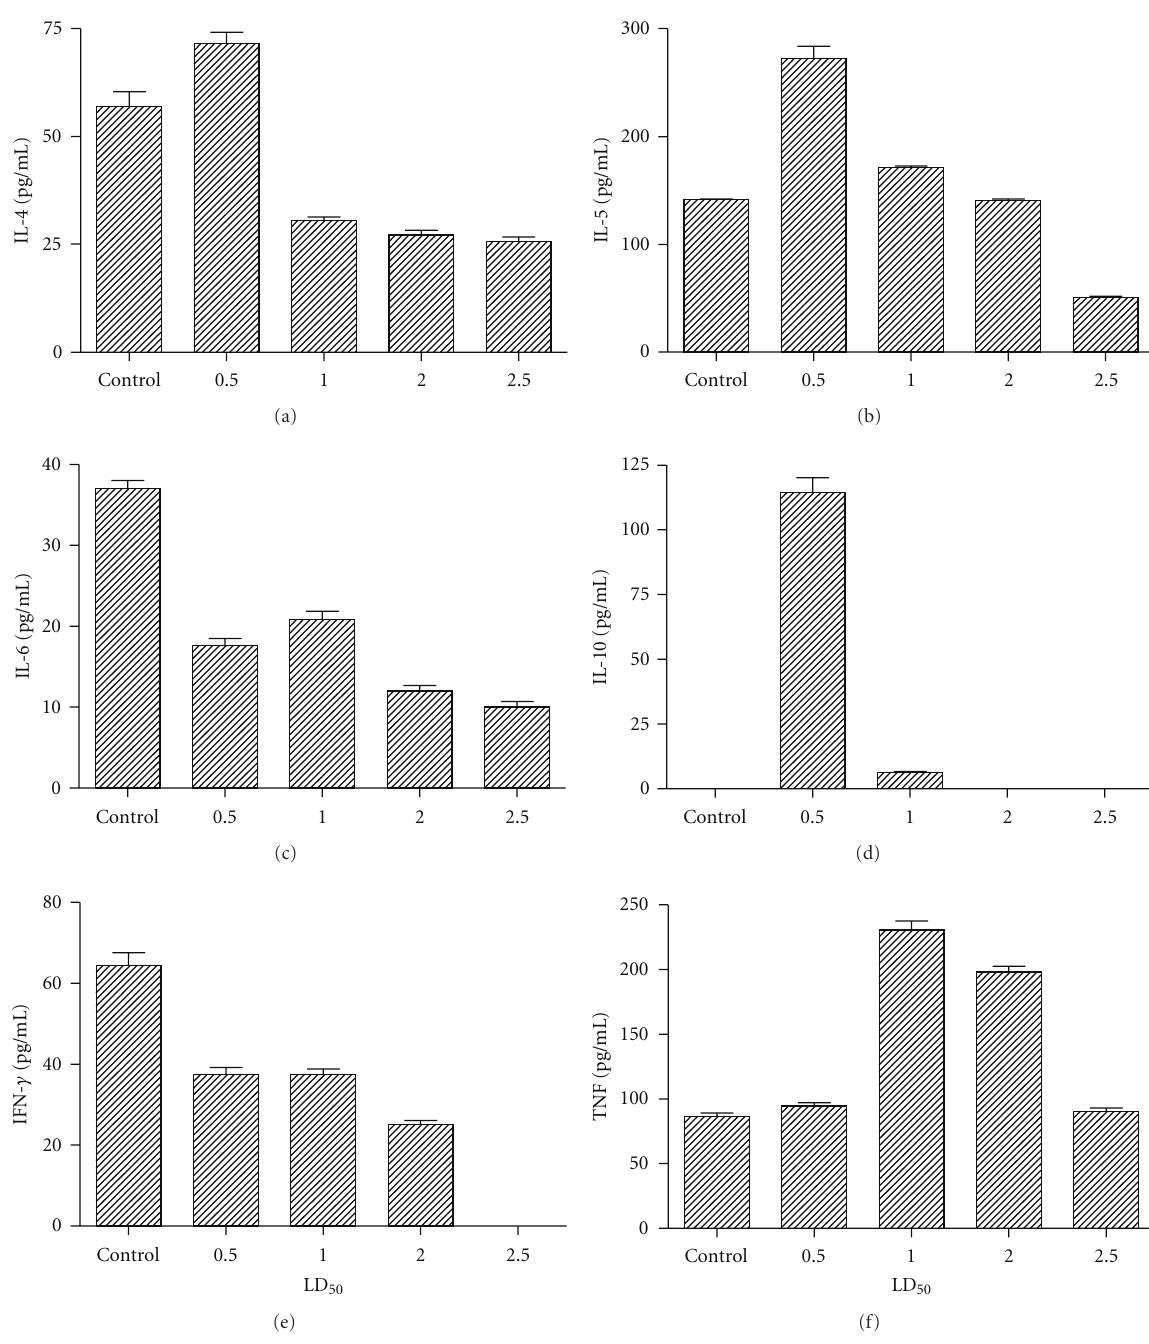
Figure 2: Cytokine excreted in urine from BALB/c female mice. Urine of mice was obtained after i.p. injection with di ff erent amounts of Cdt as above described. The levels of IL-5 were determined after 15min, for IL-4, IL-6, IL-10, and IFN- γ after 1h. They were assayed by ELISA assay using monoclonal antibodies as the probe. TNF levels were determined after 1h by standard assay with L929 cells. Each bar represents the mean value of samples from four experiments in di ff erent groups of five mice. Statistical di ff erences between the treatments were ( P > 0 . 01).